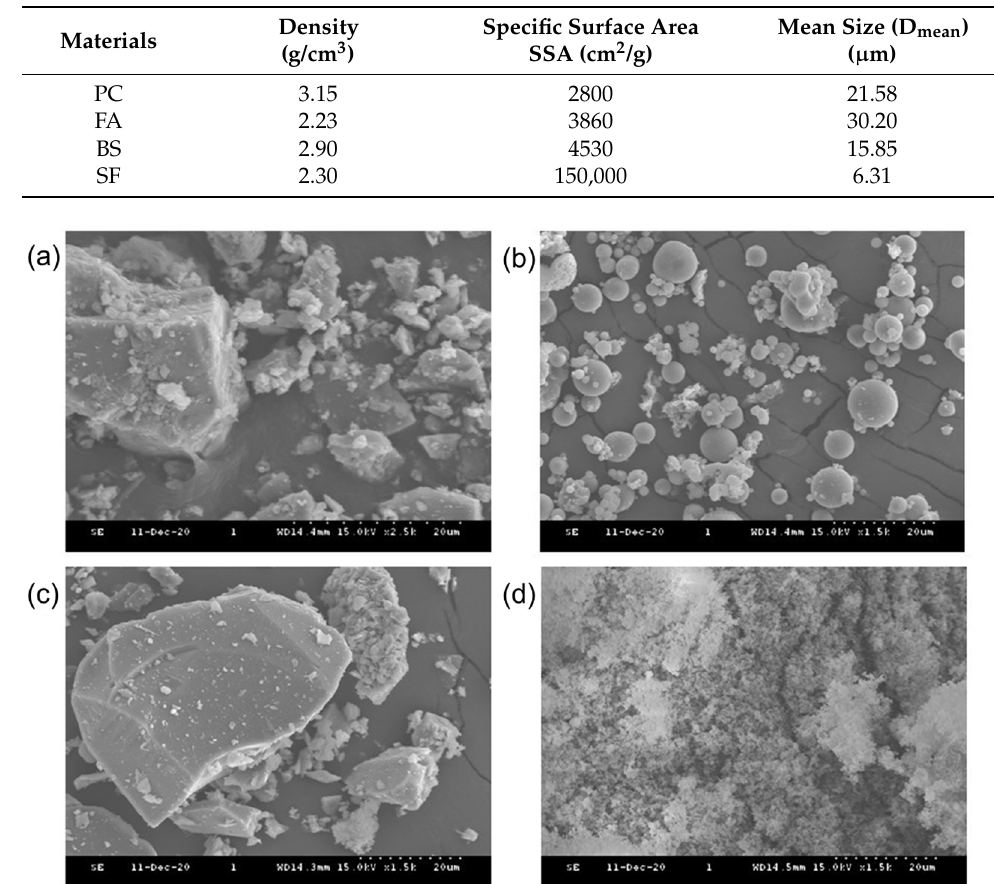
Figure 1. SEM micrographs of cementitious materials: ( a ) PC; ( b ) FA; ( c ) BS; ( d ) SF.